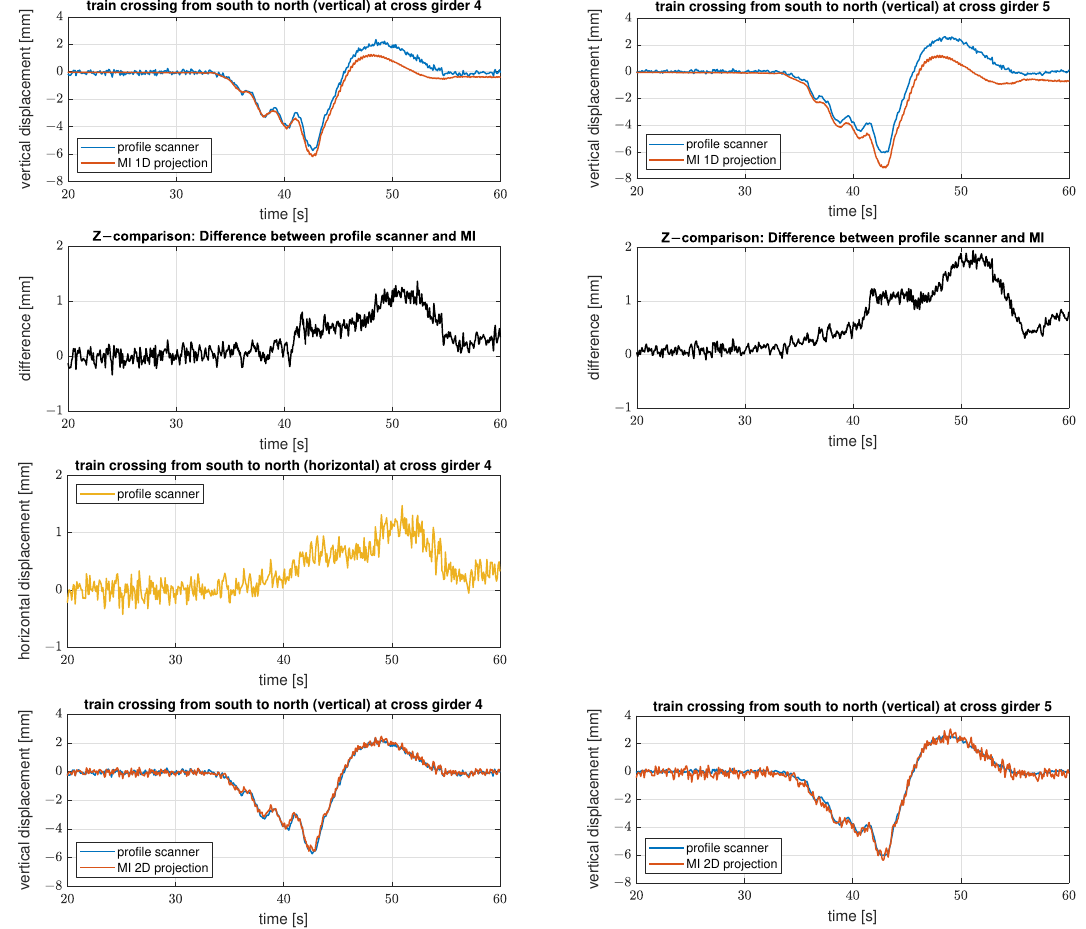
Figure 13. Comparison of the derived displacement with both measuring systems (profile scanner and MI) at cross girder 4 (left side) and cross girder 5 (right side) for setup 3. The figures in line 1 show the measurements of the IMAGER 5016 in profile mode in blue and the 1D-projected IBIS-S measurements in red, and in line 2 the respective differences are displayed in black. In line 3 the horizontal displacements measured with the IMAGER 5016 in profile mode at cross girder 4 are presented in yellow. Line 4 shows the measurements of the IMAGER 5016 in profile mode in blue and the 2D-projected IBIS-S measurements in